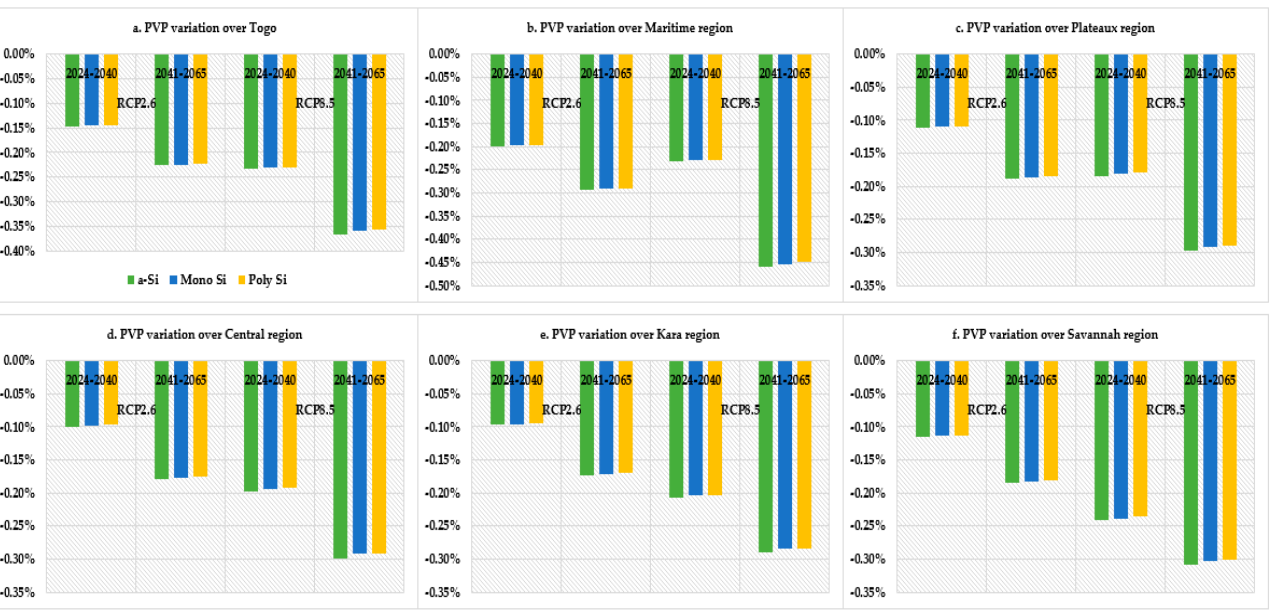
Figure 10. Monthly average reduction in PVP from 2024–2065 under RCP2.6 and 8.5 scenarios over Togo for a-Si technology.